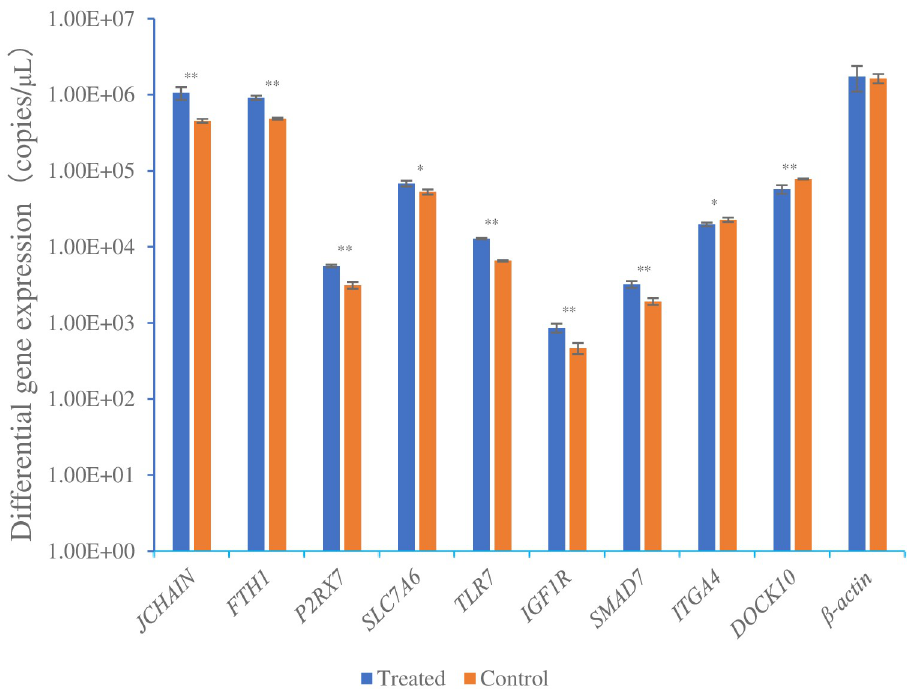
Fig 5. Detection of differentially expressed genes by absolute qPCR. Experimental data were analyzed by one-way ANOVA with SPSS 23.0 software and Duncan’s method was used for multiple comparisons � P < 0 . 05 , �� P < 0 . 01 .